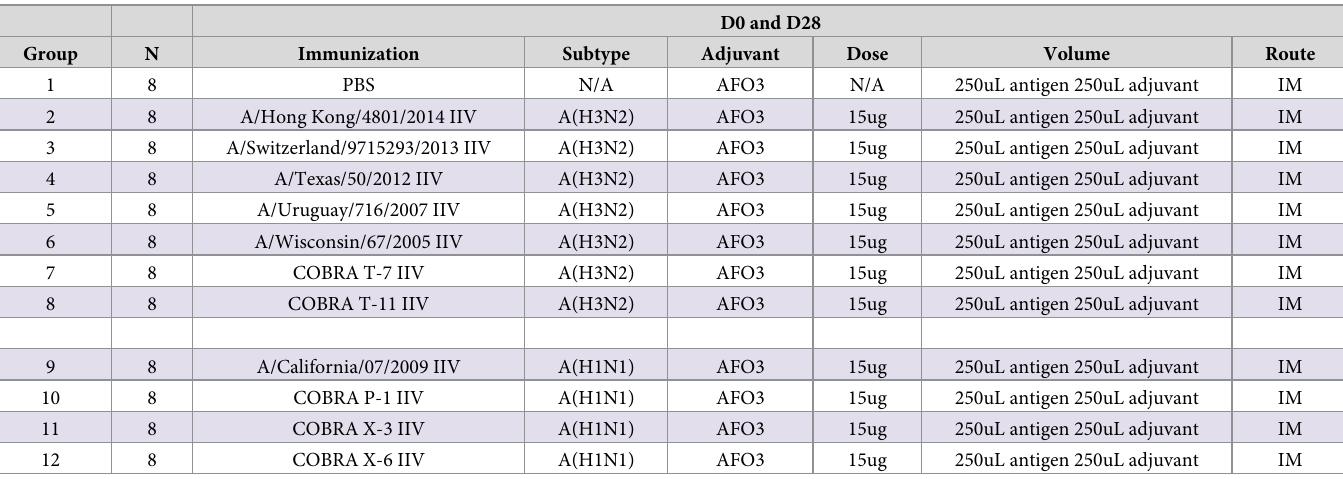
Table 1. Vaccination schema of naïve